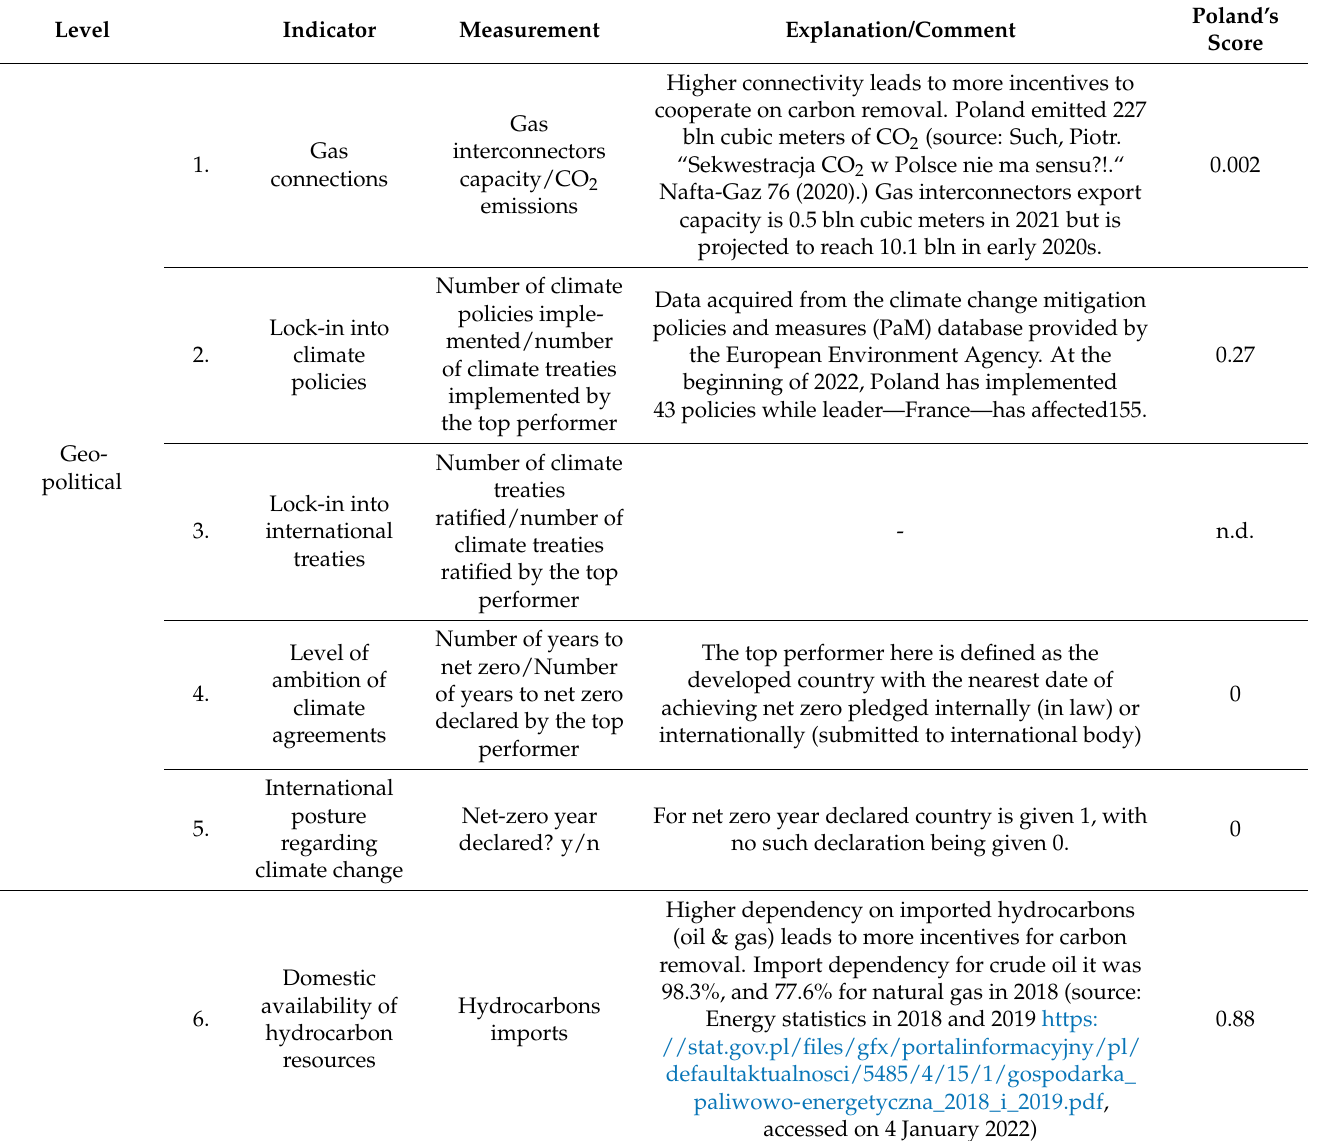
Table A1. Political readiness level assessment for